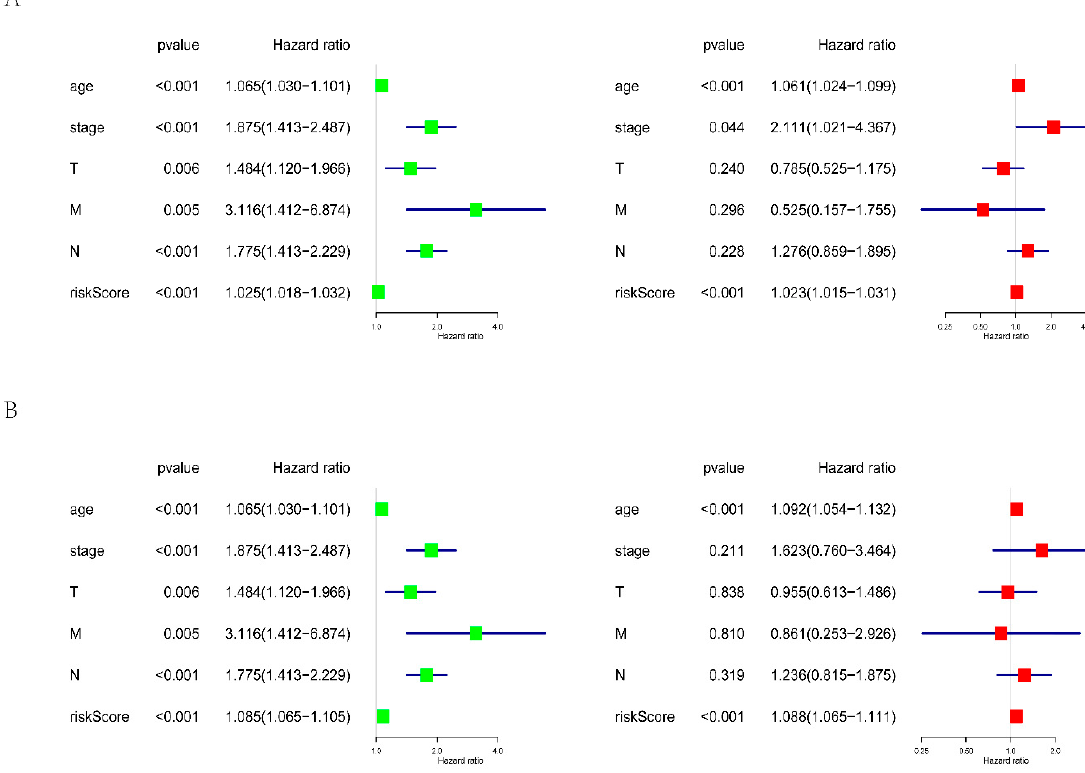
Figure 6. Univariate (left) and multivariate (right) independent prognostic analysis by Cox regression. Green dots represent the hazard ratio of di ff erent clinical parameters in univariate regression analysis, and red dots represent the hazard ratio of di ff erent clinical parameters in multivariate regression analysis. Independent prognostic analysis based on ( A ) a PS–ES model and ( B ) a PS–AA model. T: tumor; M: metastasis; N: lymph node. Table 2. Univariate and multivariate Cox regression analysis of eight PS models and clinical indexes of GBC patients.